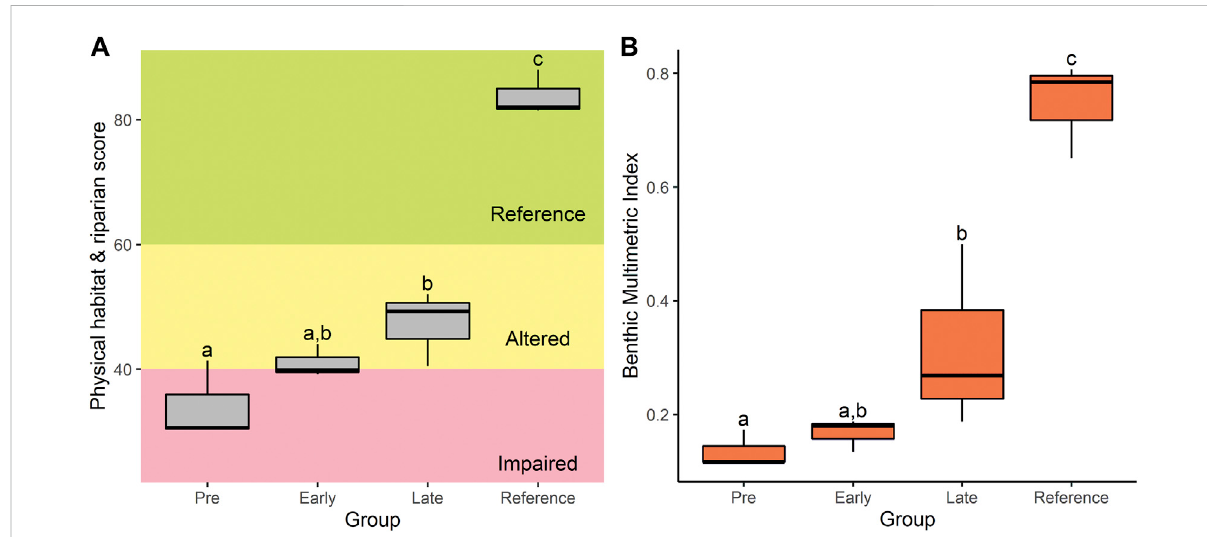
FIGURE 5 Differences in physical habitat structure and multimetric index scores pre-rehabilitation, early post-rehabilitation, late post-rehabilitation, and reference sites: (A) Instream physical habitat and riparian zone index scores; (B) Benthic multimetric index scores.